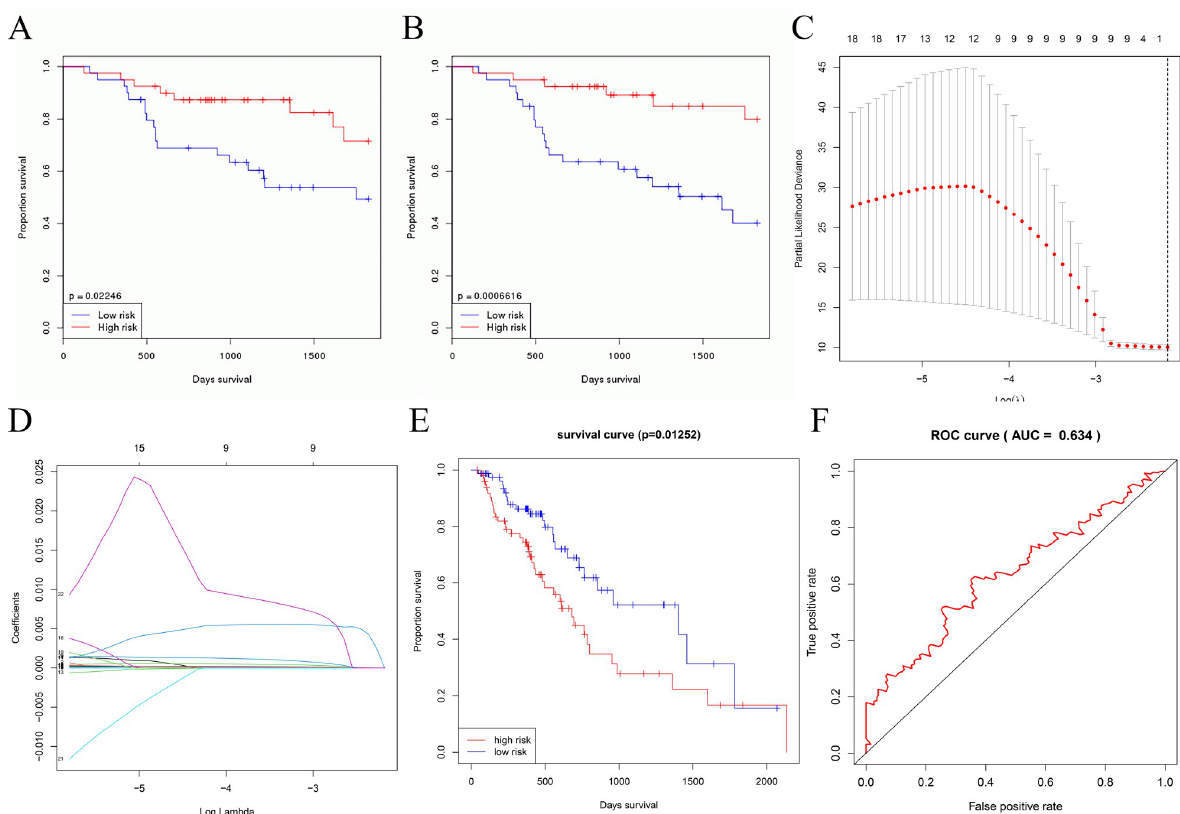
Fig 4. Prognostic risk models for ZBTB16, AQP4, ADCYAP1R1, PDGFD, VIPR2 and survival curves for miR-99a-5p and miR-508-5p. (A) and (B) indicate the survival curves of miR-99a-5p and miR-508-5p, respectively. The higher the expression of miR-99a-5p and miR-508-5p in esophageal cancer, the better the prognosis of patients. (C-F) indicate the cvfit plot, lambda plot, survival curve and ROC curve of the LASSO regression of the genetic prognostic model, respectively.